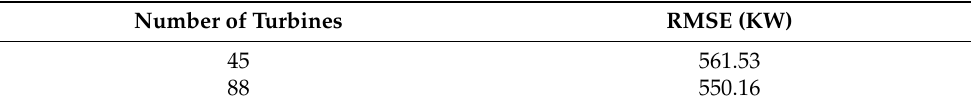
Figure 9. The power curve and power observation values for the chosen wind turbines: ( a ) power curve for Turbine 1 and power observation values for NO.45 turbine; ( b ) power curve for Turbine 2 and power observation values for NO.88 turbine.